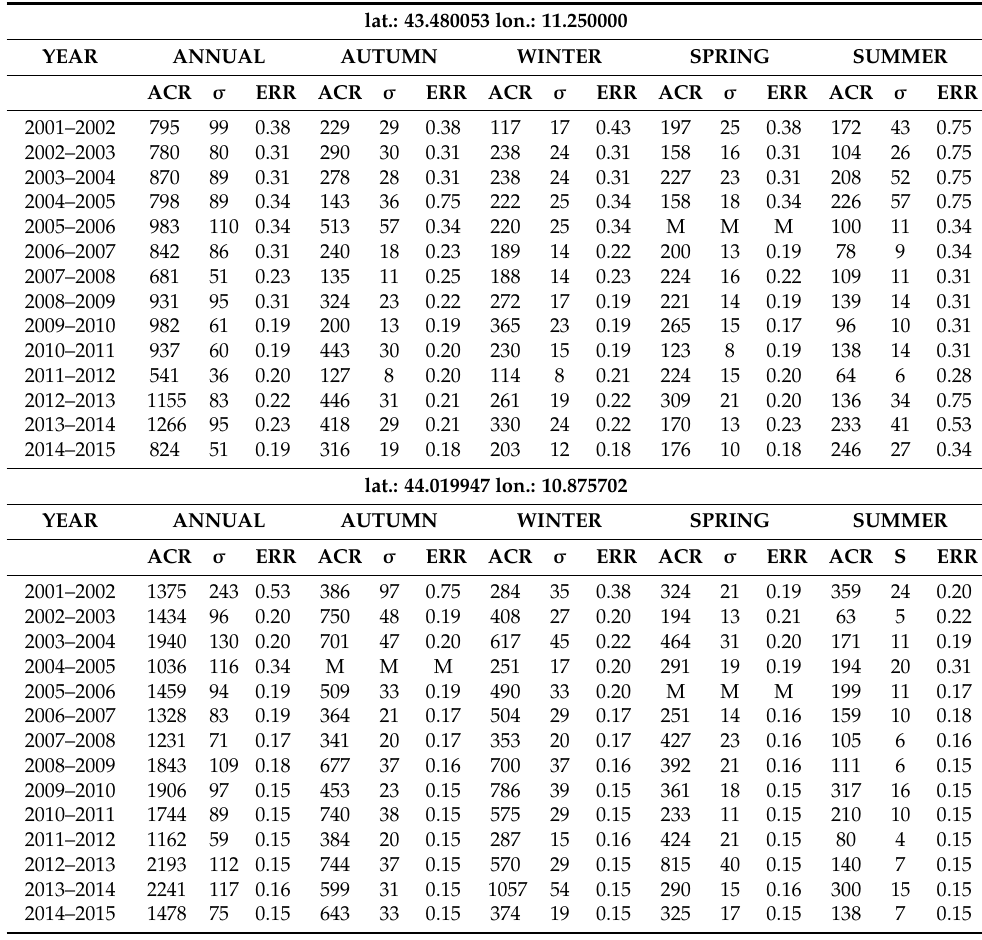
Table 1. Examples of annual and seasonal ACR (mm) and their standard deviations ( σ ) and relative errors (ERR). M denotes missing values. Latitude and longitude are expressed in decimal